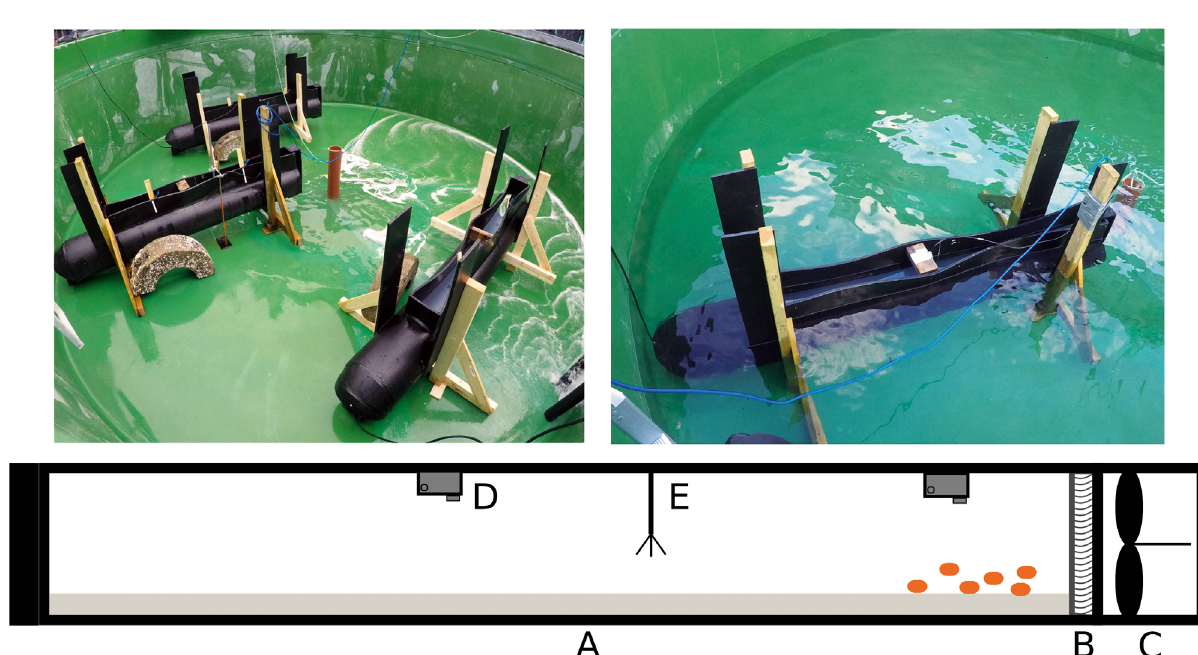
1. Experimental setup for remobilization experiments. Intact faecal pellets (in orange) were carefully placed near the start of the raceway and inside the field of vision of the front camera to register the onset of particle movement during the